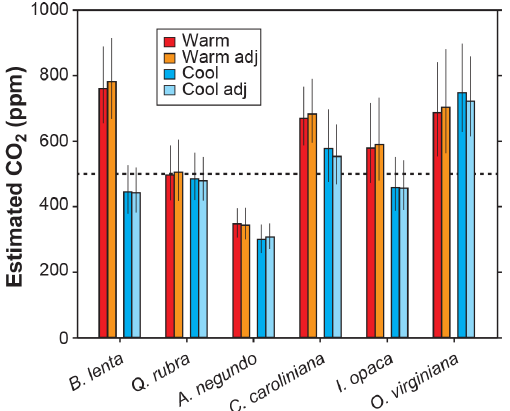
Figure 5. Estimates of CO 2 for plants grown inside growth cham- bers at daytime air temperatures of 28 and 20 ◦ C. Also shown are estimates after taking into account the temperature sensitivity of gas diffusion ( d/v ) and the CO 2 compensation point in the absence of dark respiration ( (cid:48) ∗ ) (“adj”; see also Fig. 4). Dashed line is the cor- rect CO 2 concentration (500ppm). Uncertainties in the estimates correspond to the 16th–84th percentile range.